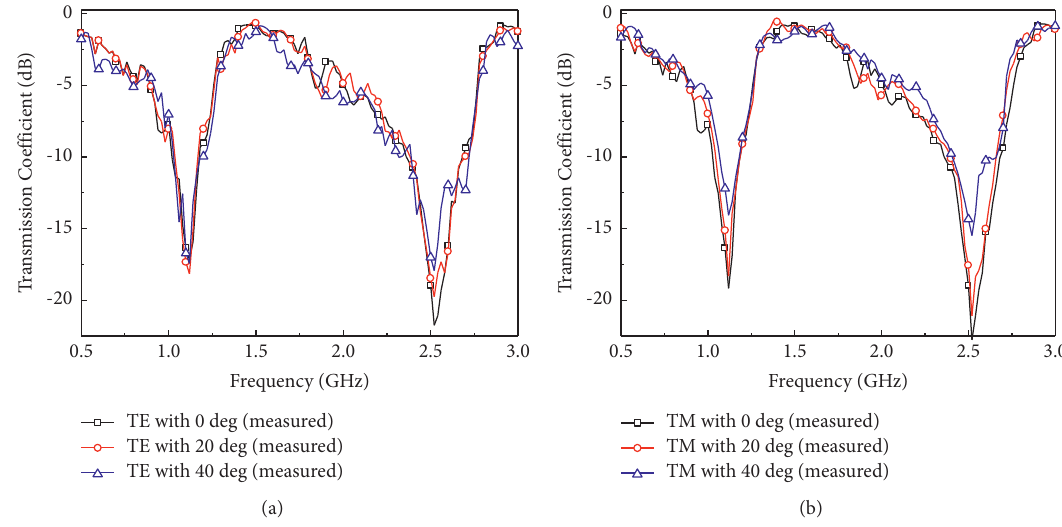
Figure 8: Measurement results of transmission coefficients of the dual-band FSS with various incident angles: (a) TE polarization; (b) TM